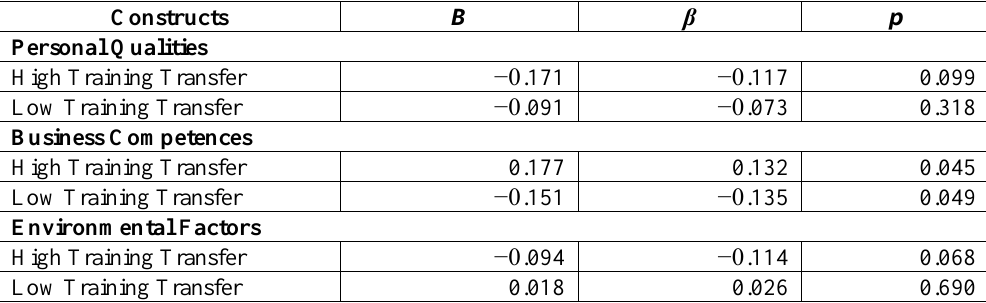
Table 2. Results of Moderation Test of Training Transfer on the Relationship between the Determinants and Entrepreneurial